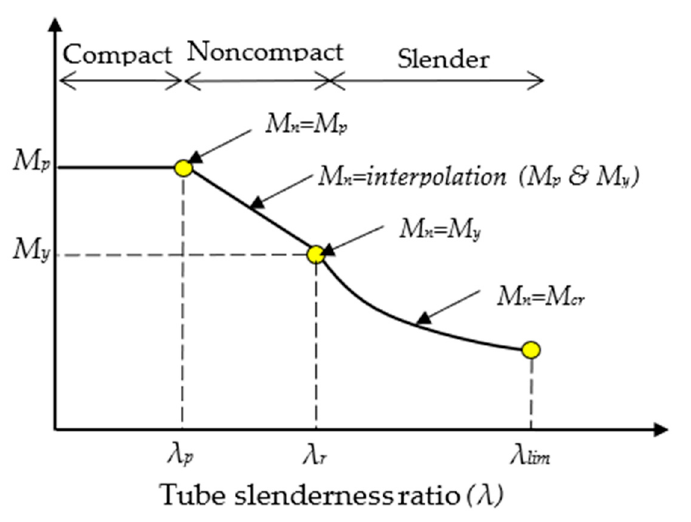
Figure 13. Moment vs. slenderness ratio relationship of the tube’s cross-section.